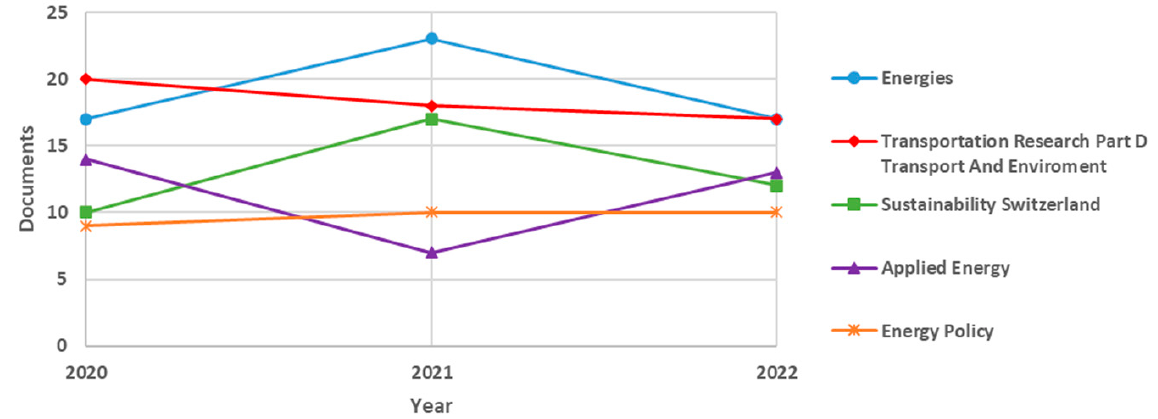
Figure 2. Documents per year by source .